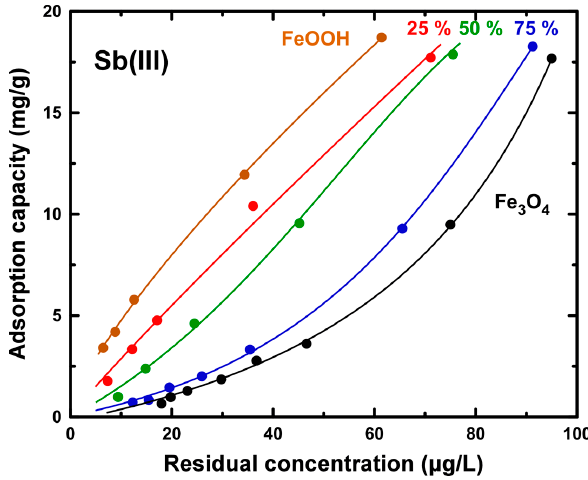
Figure 5. Adsorption isotherms of studied Fe 3 O 4 /FeOOH nanocomposites for Sb(III) taken in natural-